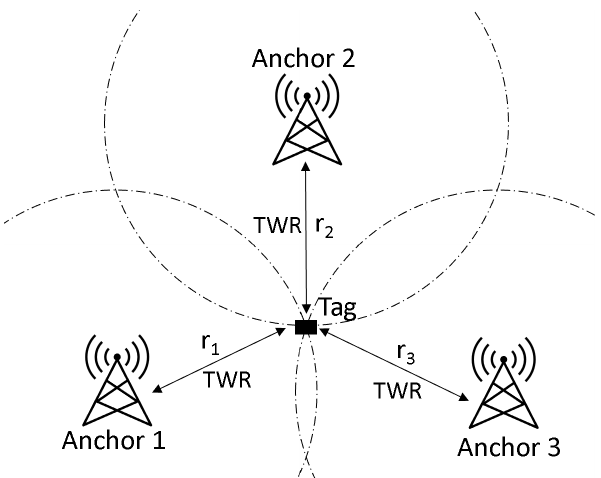
Figure 1. UWB measuring method